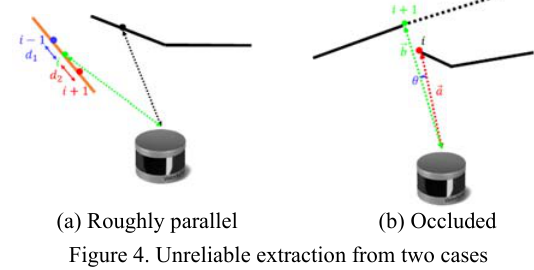
Figure 4. Unreliable extraction from two